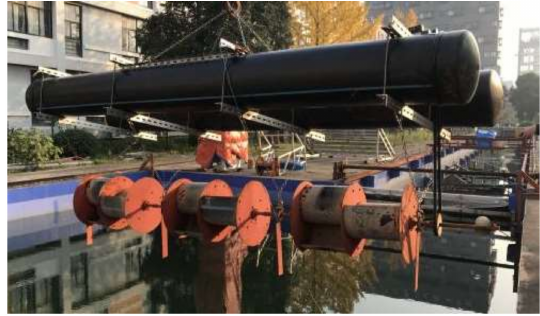
Figure 12. Flexible breakwater with Savonius